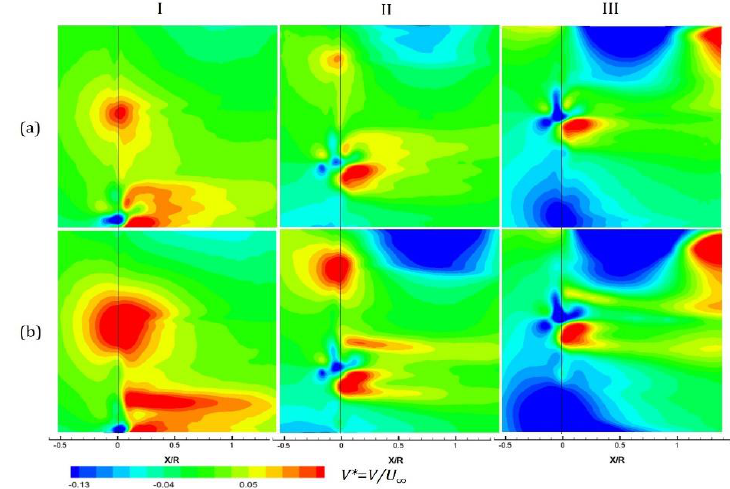
Figure 4. Time-averaged contours of normalized vertical velocity ( V* = V/U ∞ ) for rotational speeds of 180 RPM (row a) and 270 RPM (row b) for 𝛿ℎ 𝑈 0.55 (column I), 0.27 (column II), and 0.05 (column III).